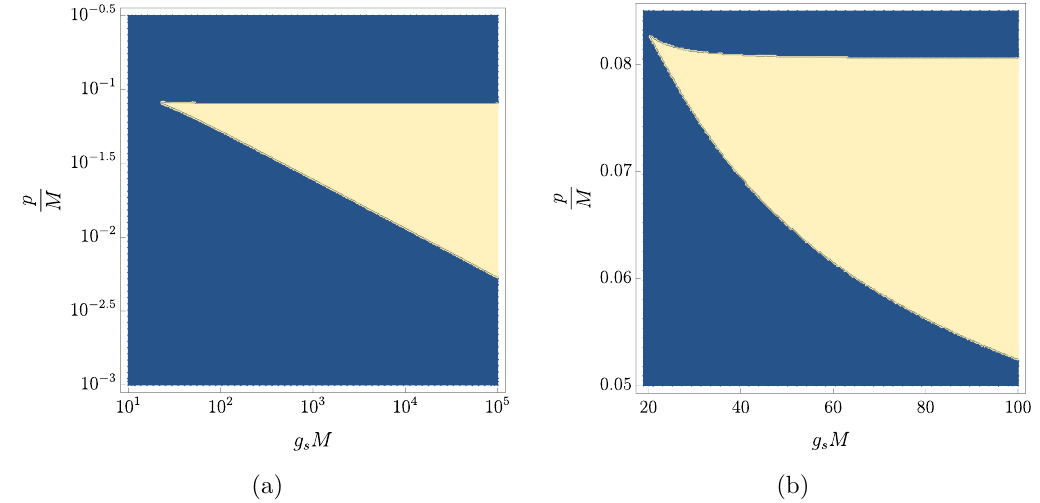
Figure 3. The yellow area shows the region in the ( g s M, p/M ) -parameter space where a meta-stable minimum exists. (a) is a log-log-plot for a wide range of parameters and (b) zooms into the region of smallest allowed values of g s M